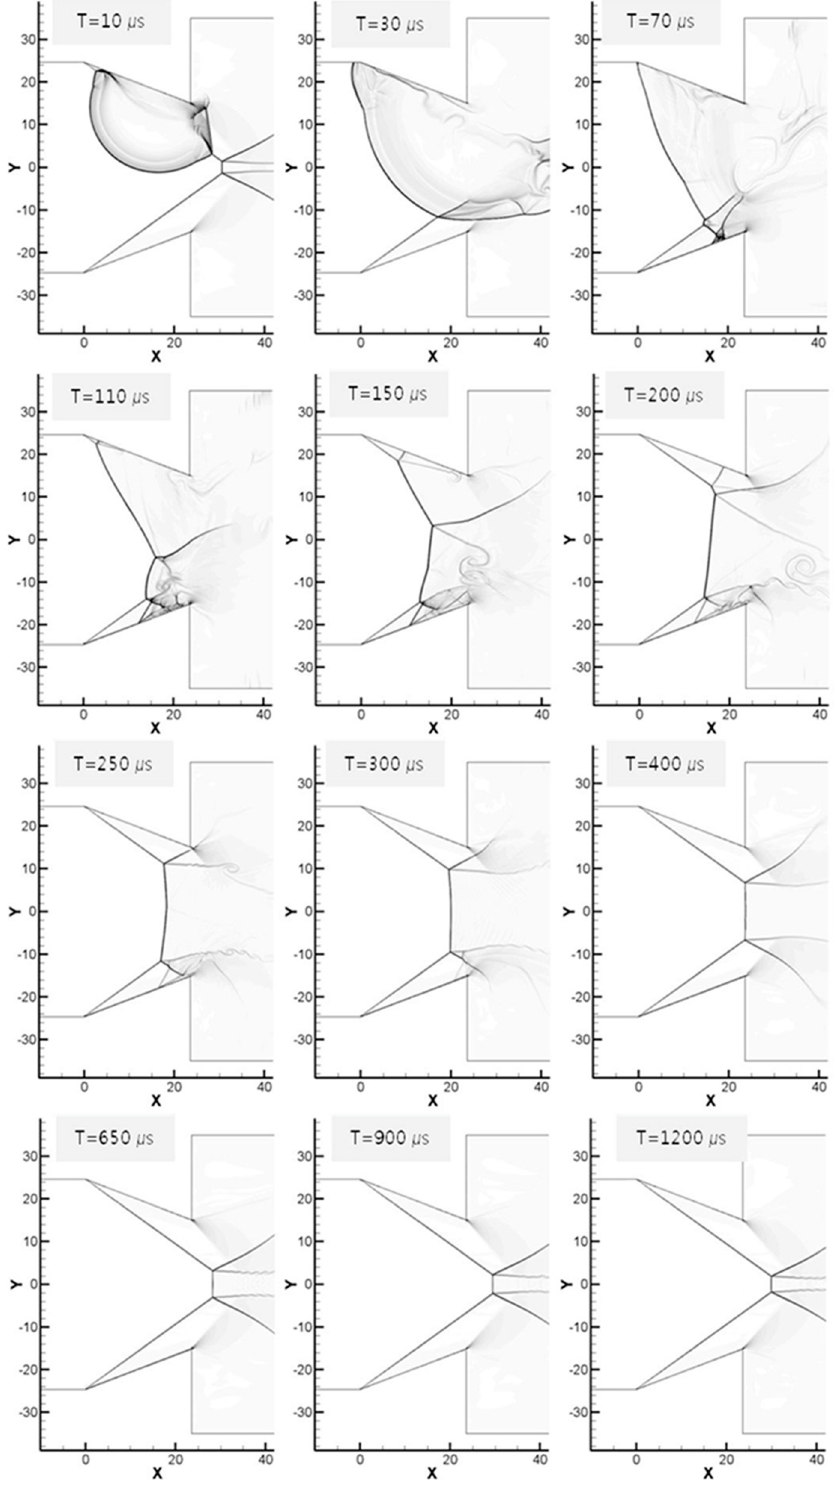
Figure 14. Interaction between blast wave and oblique shock, deposition at the middle of the upper wedge. Energy: 430.0 mJ. wedge. Energy: 430.0